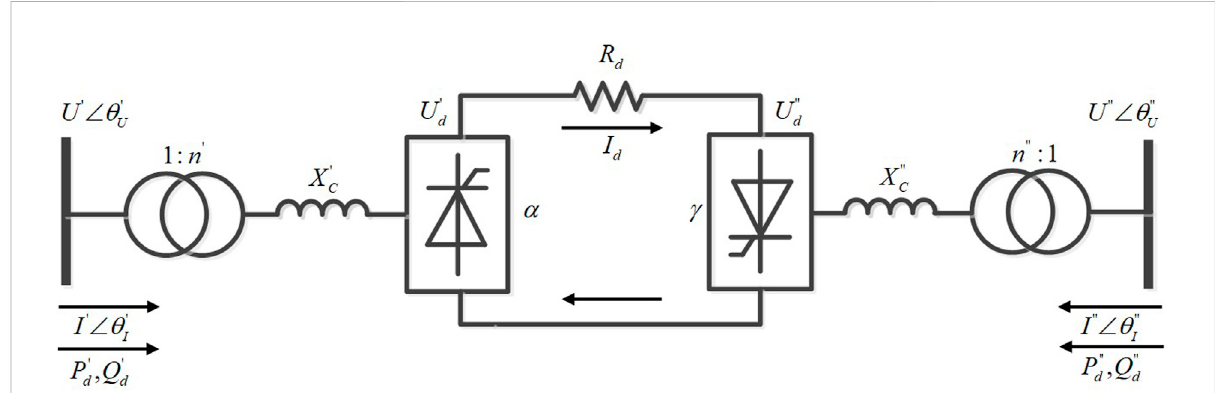
FIGURE 3 Schematic diagram of LCC-HVDC transmission